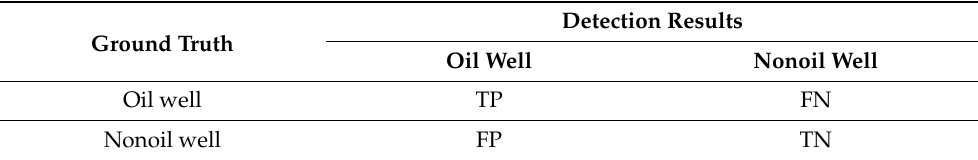
Table 1. Confusion matrix of oil well detection.